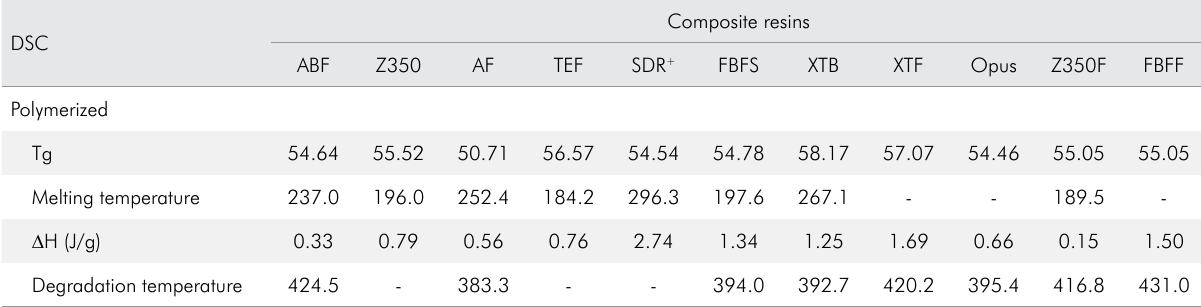
Table 4. Mean glass transition temperature (Tg), Δ H, melting and degradation temperatures.